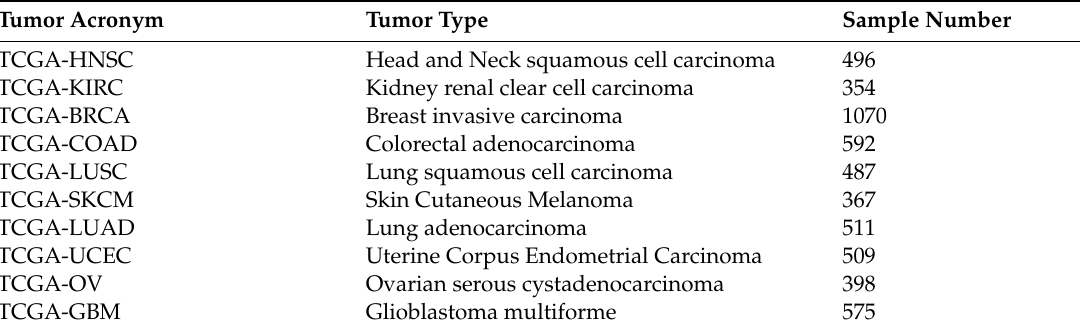
Table 1. Summary of the tumor types, with acronyms and